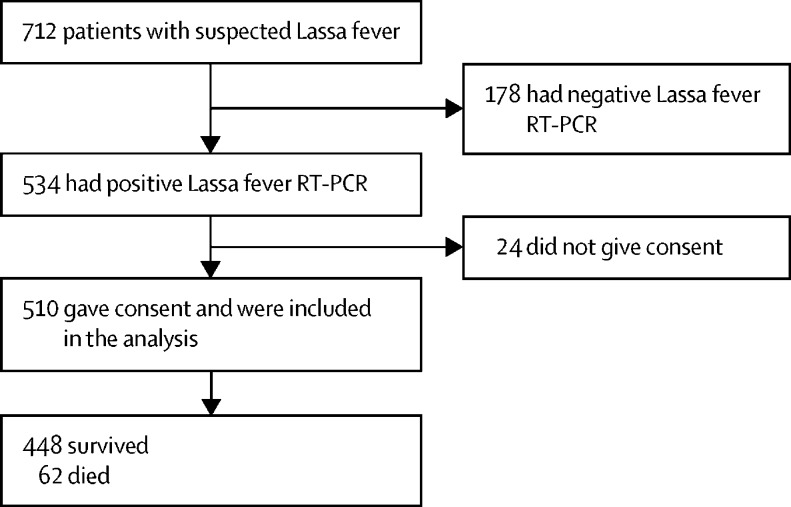
Flow chart of participants